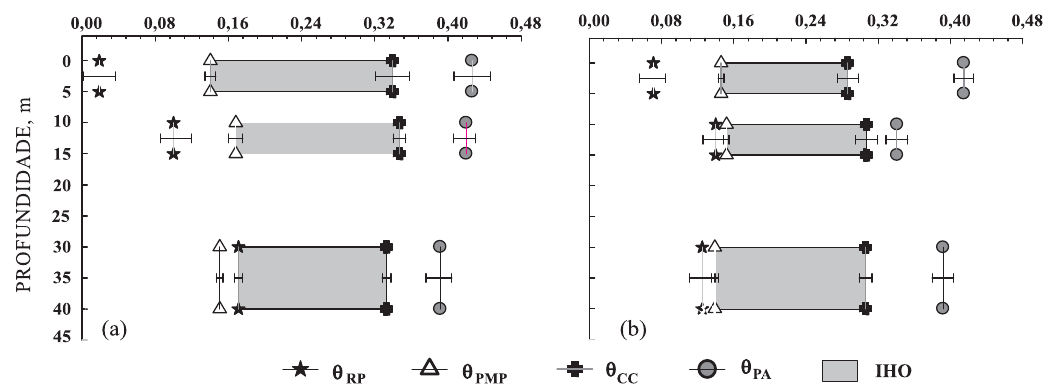
Figura 2. Variação do conteúdo de água no solo ( θθ θθ θ , m 3 m -3 ) para os limites críticos de ponto de resistência do solo à penetração ( θθθθθ ), ponto de murcha permanente ( θθθθθ RP de aeração ( θθθθθ ), nas profundidades de 0 a 0,05, 0,1 a 0,15 e 0,3 a 0,4 m do Cambissolo Háplico Tb PA distrófico (CXvbd) (A) e do Latossolo Vermelho-Amarelo distrófico (LVAd) (B). IHO: intervalo hídrico